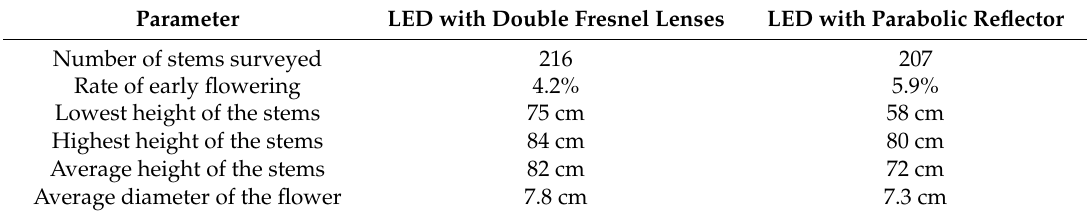
Table 2. Results of chrysanthemums after 2 months of testing.